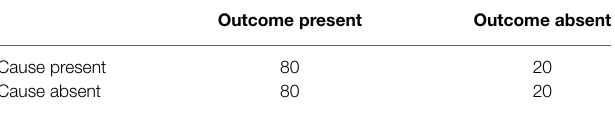
TABLE 2 | Contingency matrix showing a situation in which the outcome occurs with high probability but with no